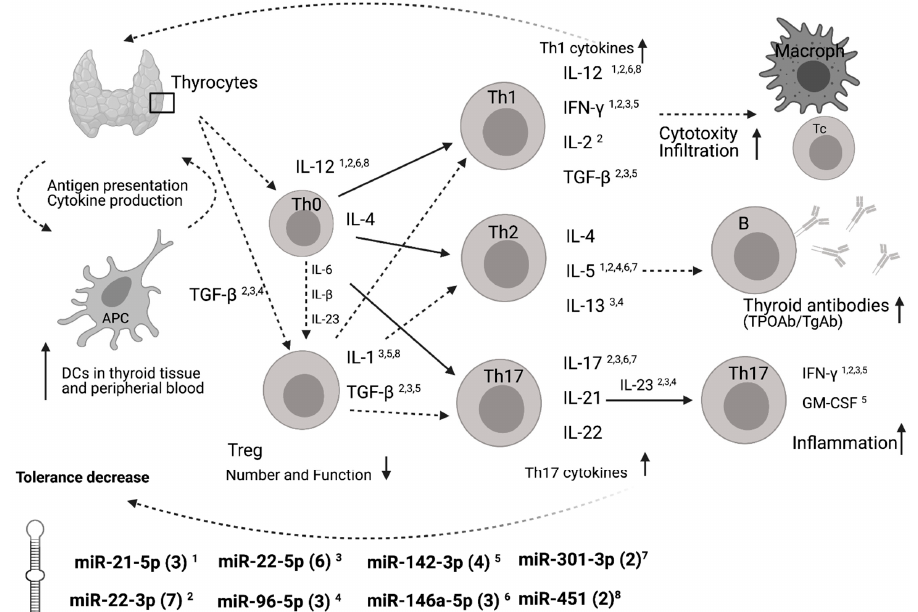
Figure 4. Summary of the main mechanisms related to autoimmunity of HT and potential interaction sites with differentially expressed miRNAs. Schematic representation of T cells differentiating into specific T cell subsets depending on the cytokines to which they are exposed and their main effects. MiRNA binding site predictions have been annotated by miRWalk database. Number of predicted binding sites are shown in brackets for each miRNA. Predicted binding sites of genes of HT immune-related molecules and/or their receptors are marked by superscript numbers. Adapted from [22]. APC, antigen presenting cell; Th, T helper cell; Macroph, macrophage; DC, dentritic cell; Treg, T-regulatory cells; TPOAb; peroxidase autoantibody; TgAb, thyroglobulin autoantibody, IL, interleukin; IFN- γ , interferon- γ ; TGF- β , transforming growth factor β ; GM-CSF, granulocyte-macrophage colony-stimulating factor; miR, miRNA.